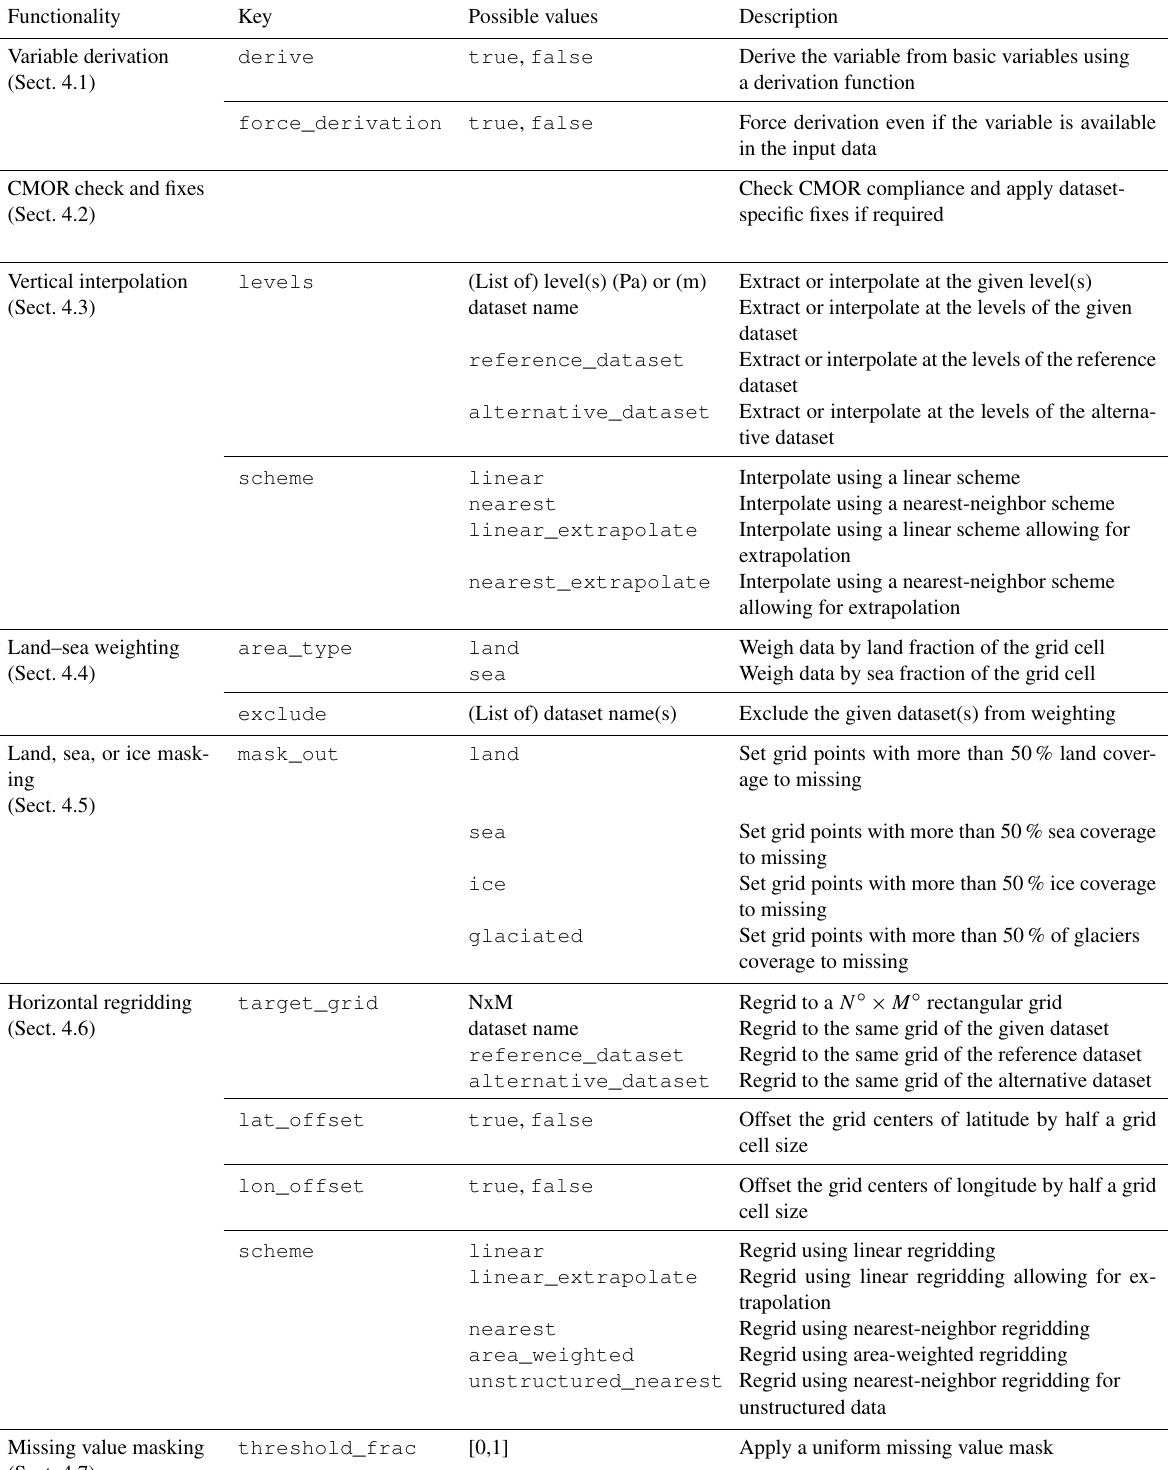
Table 1. Overview of the preprocessor functionalities and related recipe